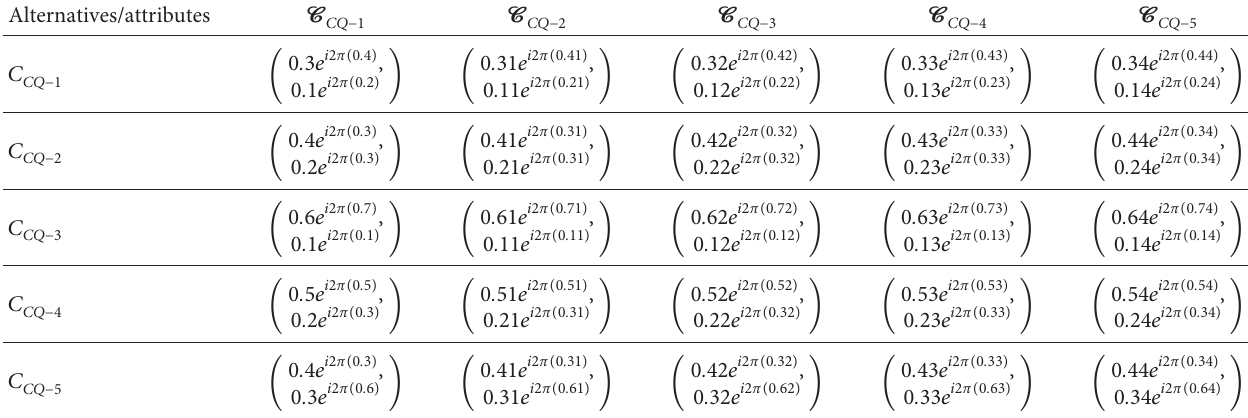
Table 5: Decision matrix in terms of CIFNs for Example 3.